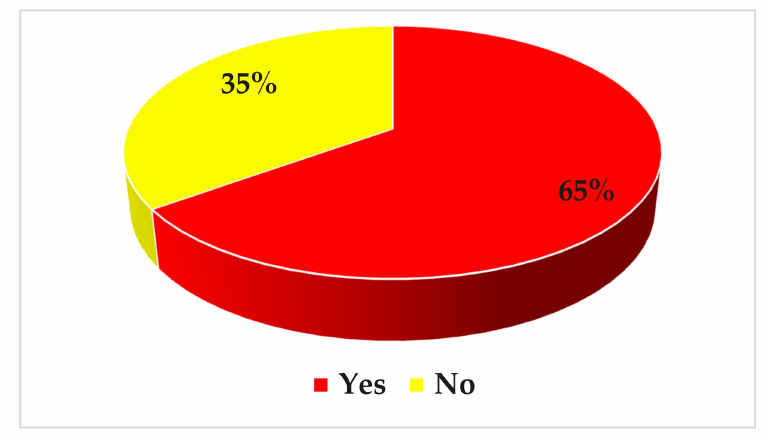
Figure 9. Characteristics of respondents based on direct social interaction with other people every day.